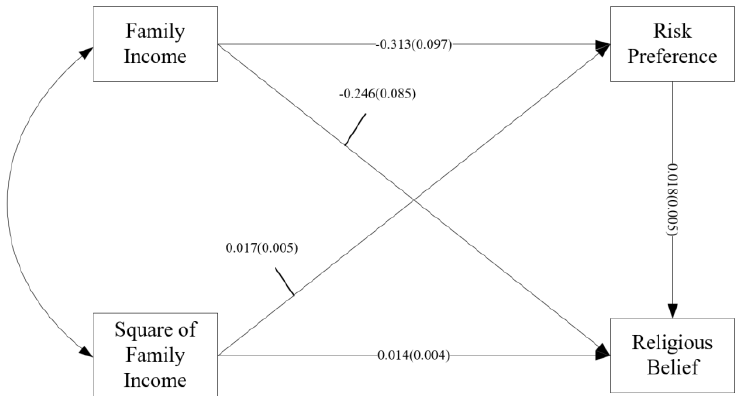
Figure 1. Path model for estimating the instantaneous indirect effect of family income on religious belief through risk